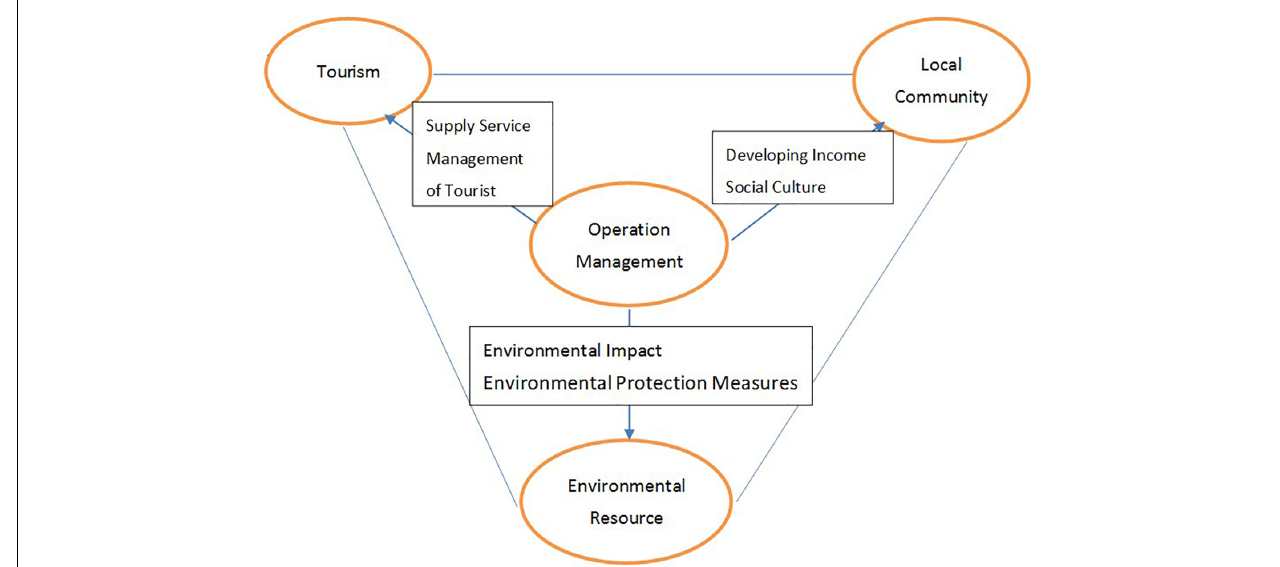
FIGURE 1 | Research